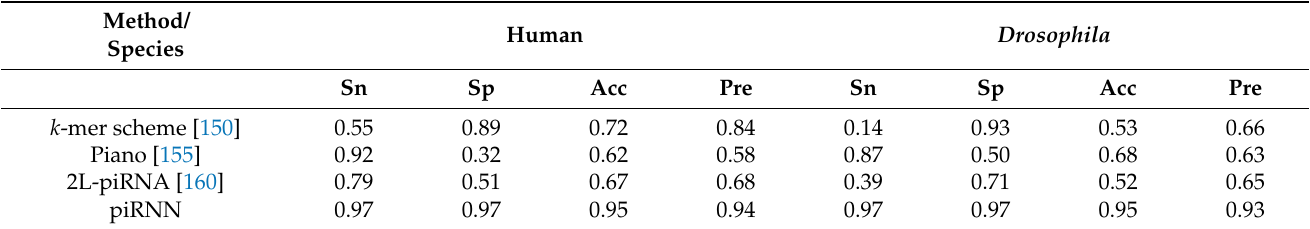
Table 7. piRNN outperforms the selected methods on piRNA datasets from both model organisms. Method/